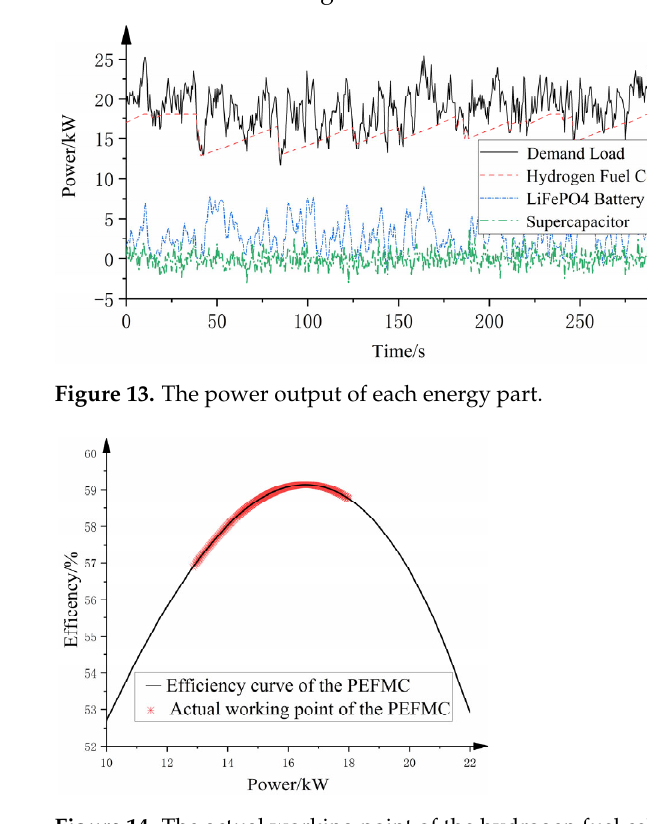
Figure 14. The actual working point of the hydrogen fuel cell.